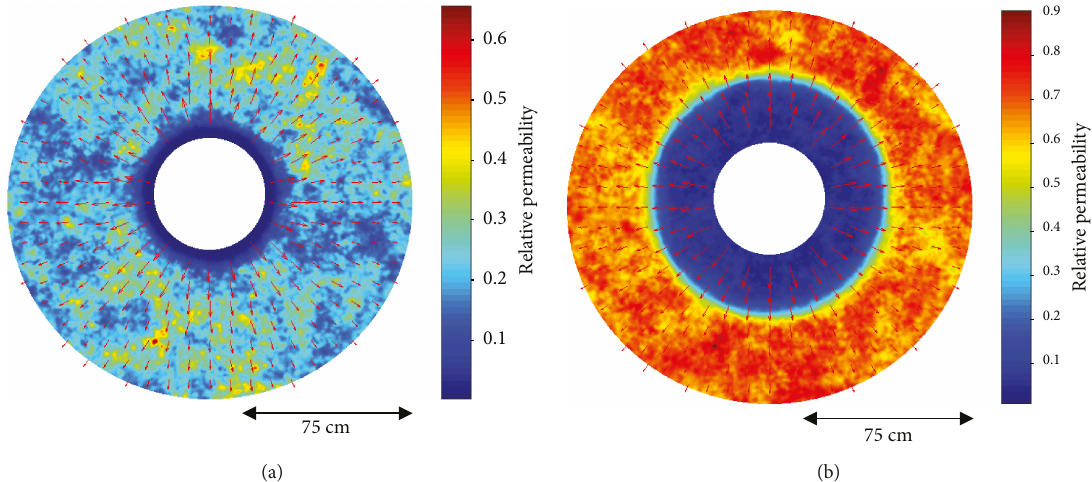
75 cm Figure 7: 2D wellbore model showing depth of penetration of wellbore occlusion damage for fl uid fl ow in spatially correlated poroperm media (wellbore near skin e ff ect, (a)) with spatially uncorrelated poroperm media (deep damage zone,